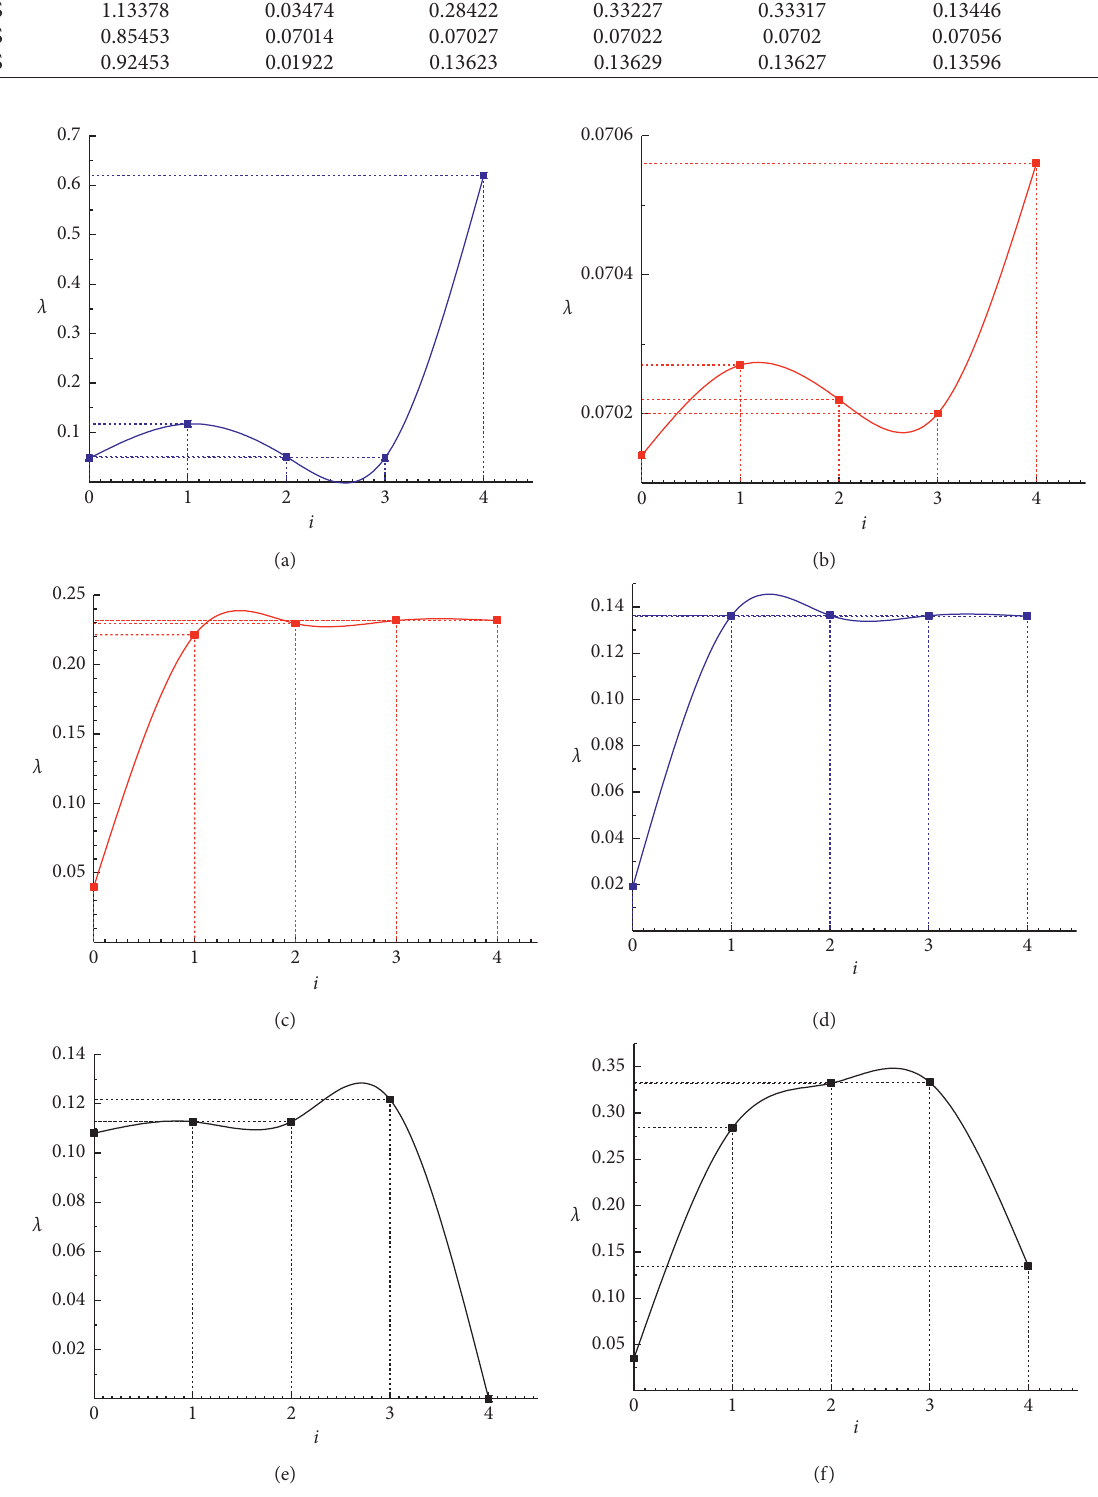
Figure 8: Relationships between different layers and scale factors by the model. (a) Z-grade of 5.8% asphalt-aggregate ratio. (b) S-grade of 5.3% asphalt-aggregate ratio. (c) Z-grade of 5.3% asphalt-aggregate ratio. (d) S-grade of 5.8% asphalt-aggregate ratio. (e) Z-grade of 4.8% asphalt-aggregate ratio. (f) S-grade of 4.8% asphalt-aggregate